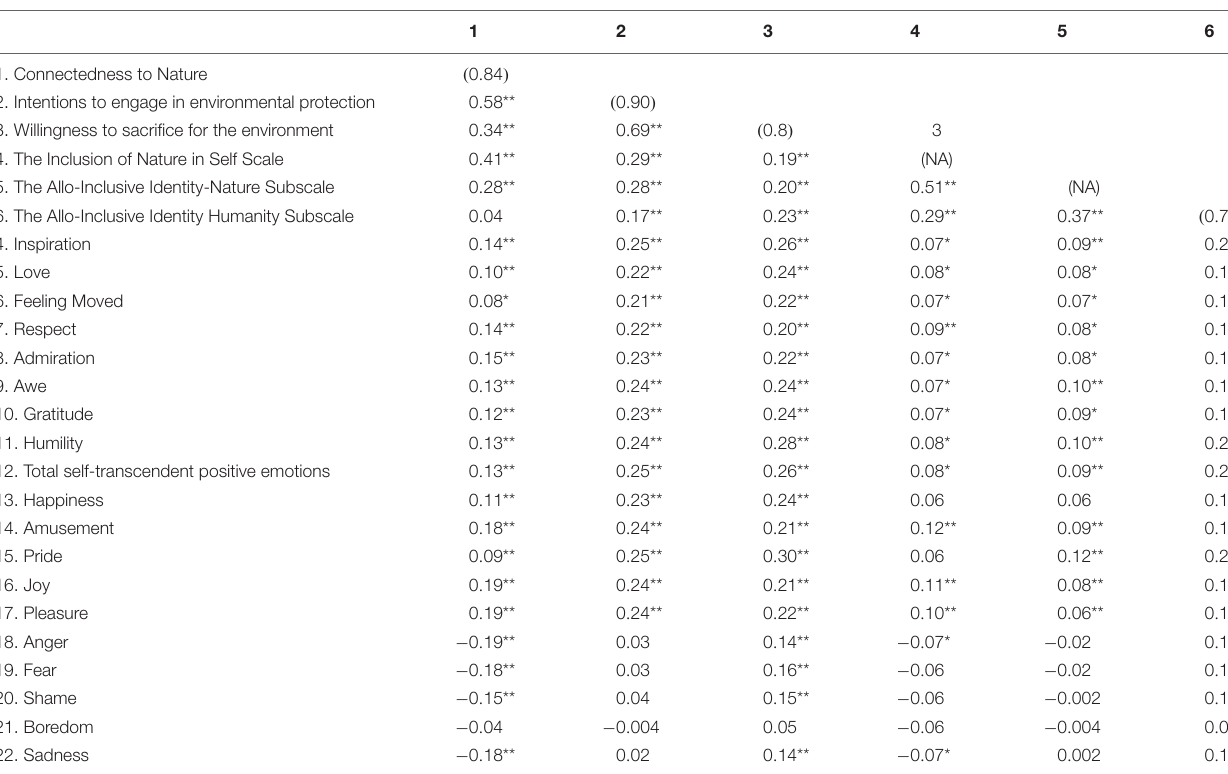
TABLE 1 | Correlations between nature-related variables and felt